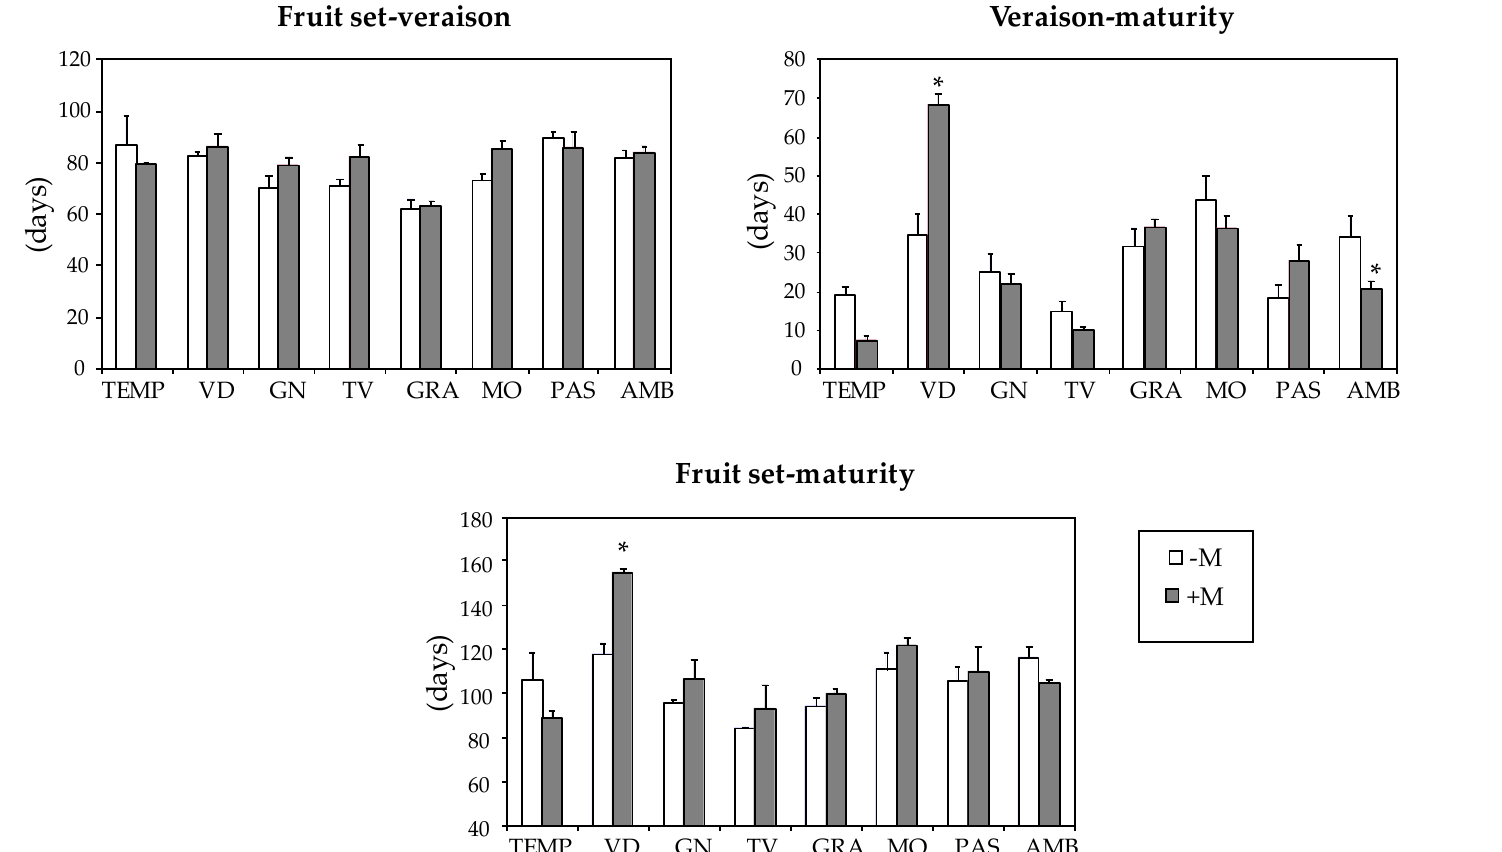
Figure 4. Main phases of berry development recorded from fruit-bearing cuttings of ancient grapevine varieties inoculated with arbuscular mycorrhizal fungi (+M) or non-inoculated (-M). Values are means ± S.E. (n = 3-4). Within each variety, asterisks (*) indicate significant differences (P ≤ 0.05) between +M and –M plants according to Duncan’s test. The variety labels can be found in Table 1.